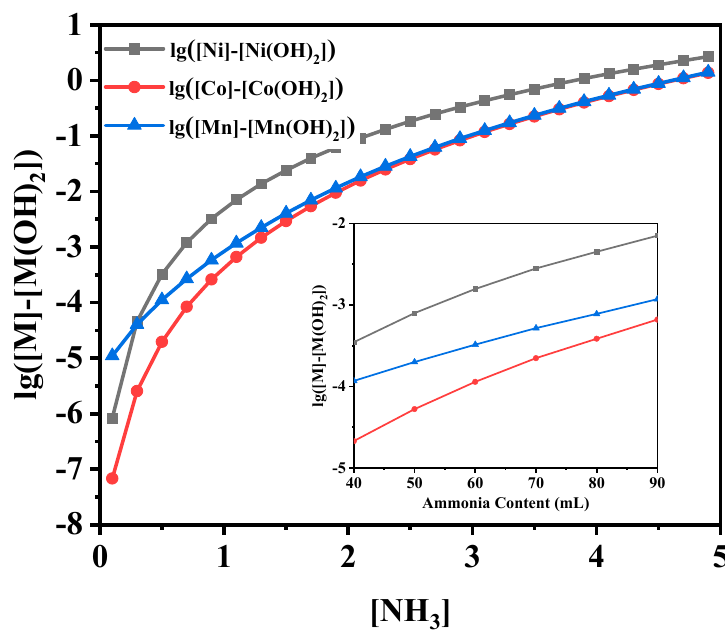
Figure 1. Relationship between total concentrations of metal ions and ammonia concentrations.